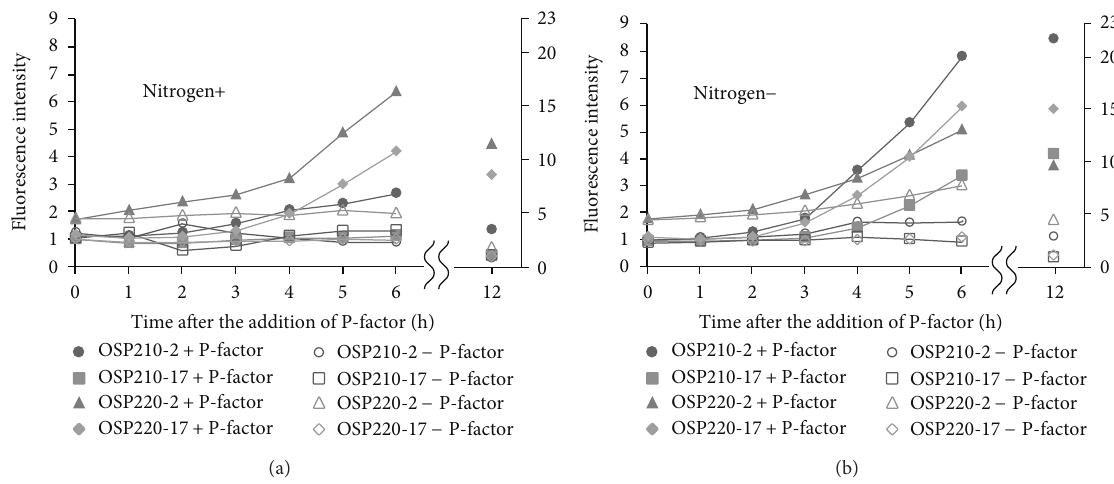
F 3: Comparison between cyr1